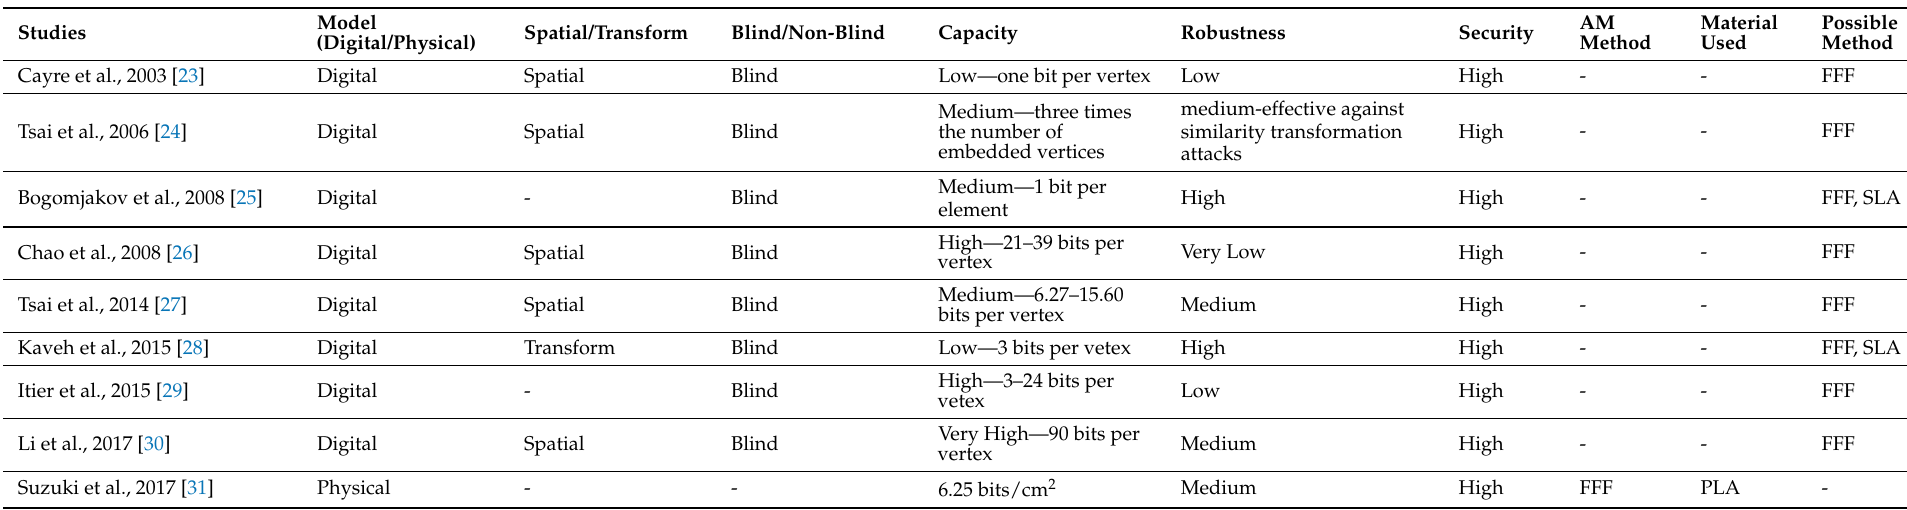
Table 3. Studies vs. steganographic